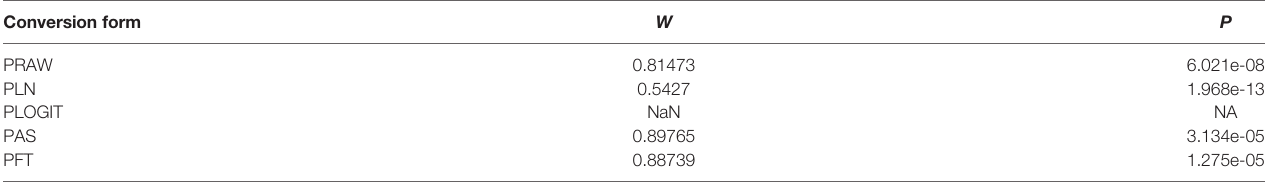
TABLE 1 | Normal distribution test for the normal rate and the different conversion of the normal rate. Conversion form W P